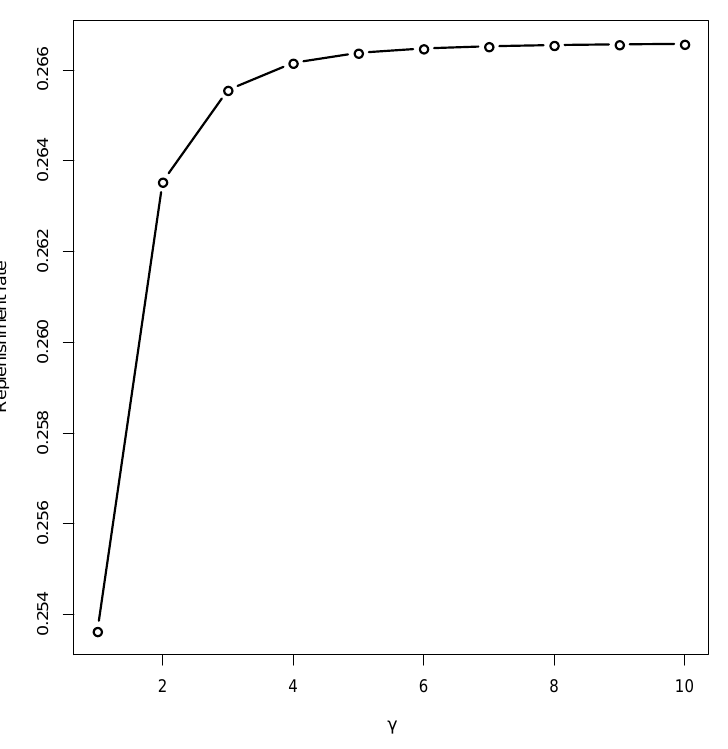
Figure 6. Dependency of ¯I ( top ) and ¯R ( bottom ) on γ = 1, . . . ,10 for S = 50, s = 5, l 2 = 10, µ 1 = 7, µ 2 = 15, MMAP arrival process parameters given in (49).